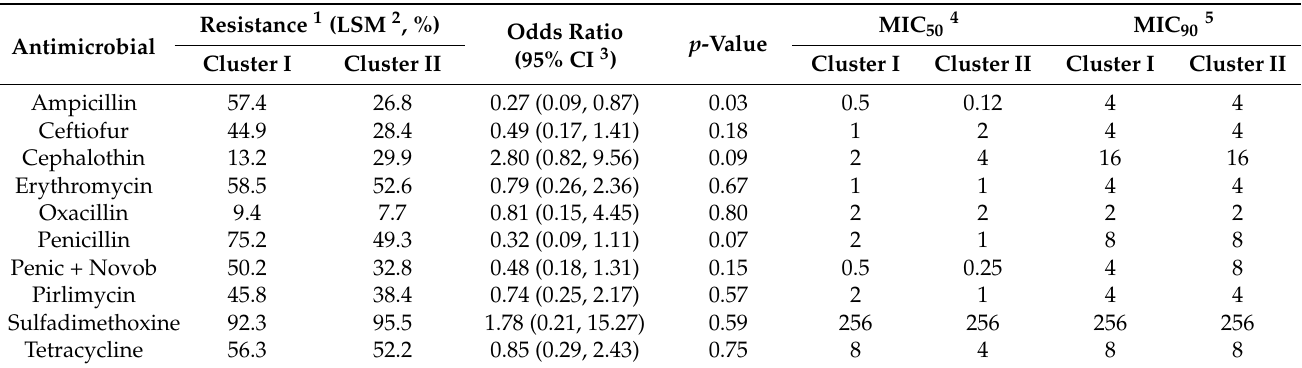
Table 3. Results of the regression models comparing the antimicrobial susceptibility of 71 Staph. aureus strains isolated from affected mammary quarters of cows with clinical mastitis according to their genetic similarity into spa-typing clusters I ( n = 32) and II ( n =